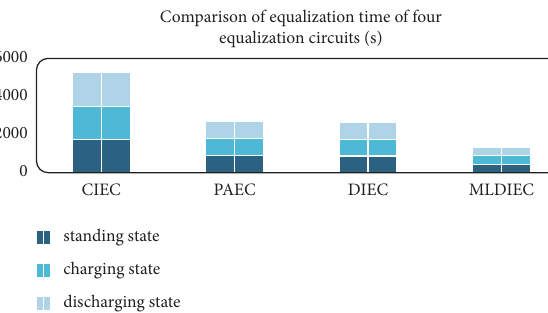
Figure 15: Comparisons of equalization time of the four equalization circuits.